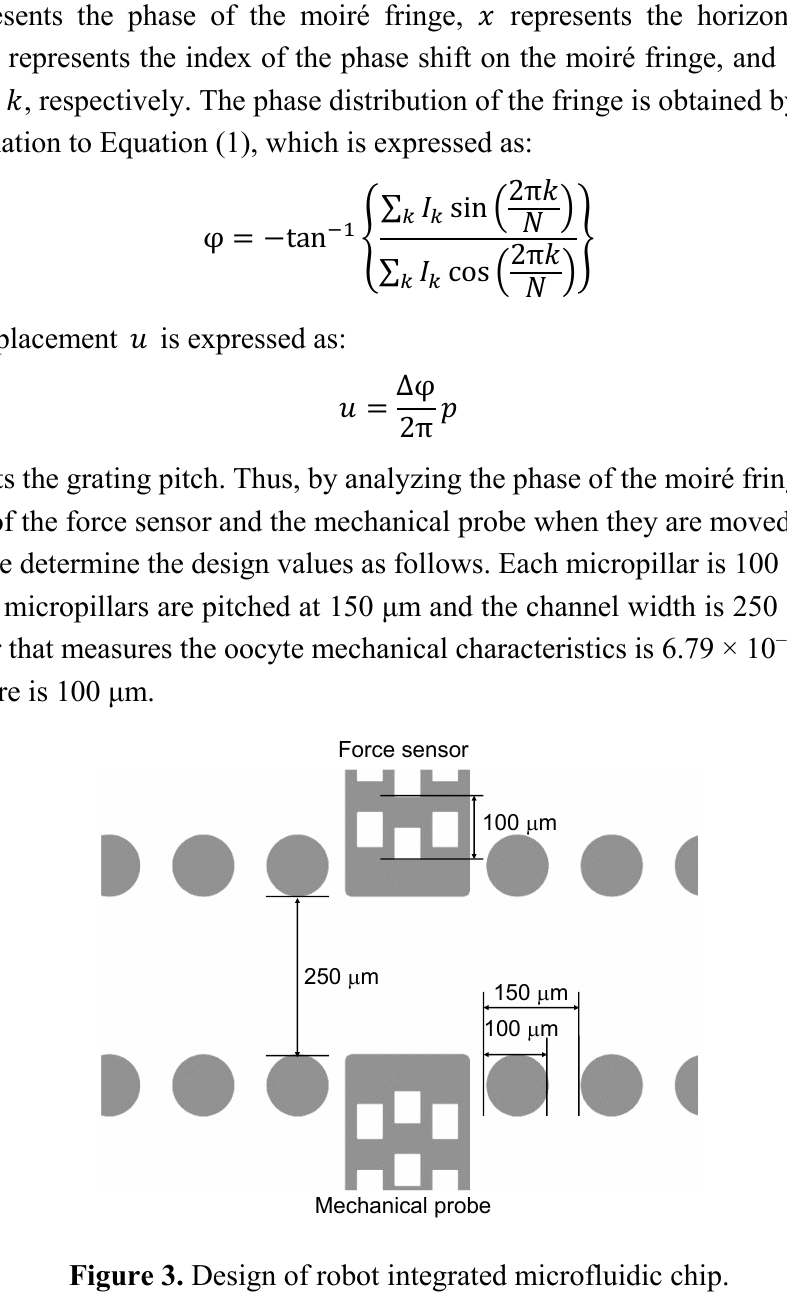
Figure 3. Design of robot integrated microfluidic